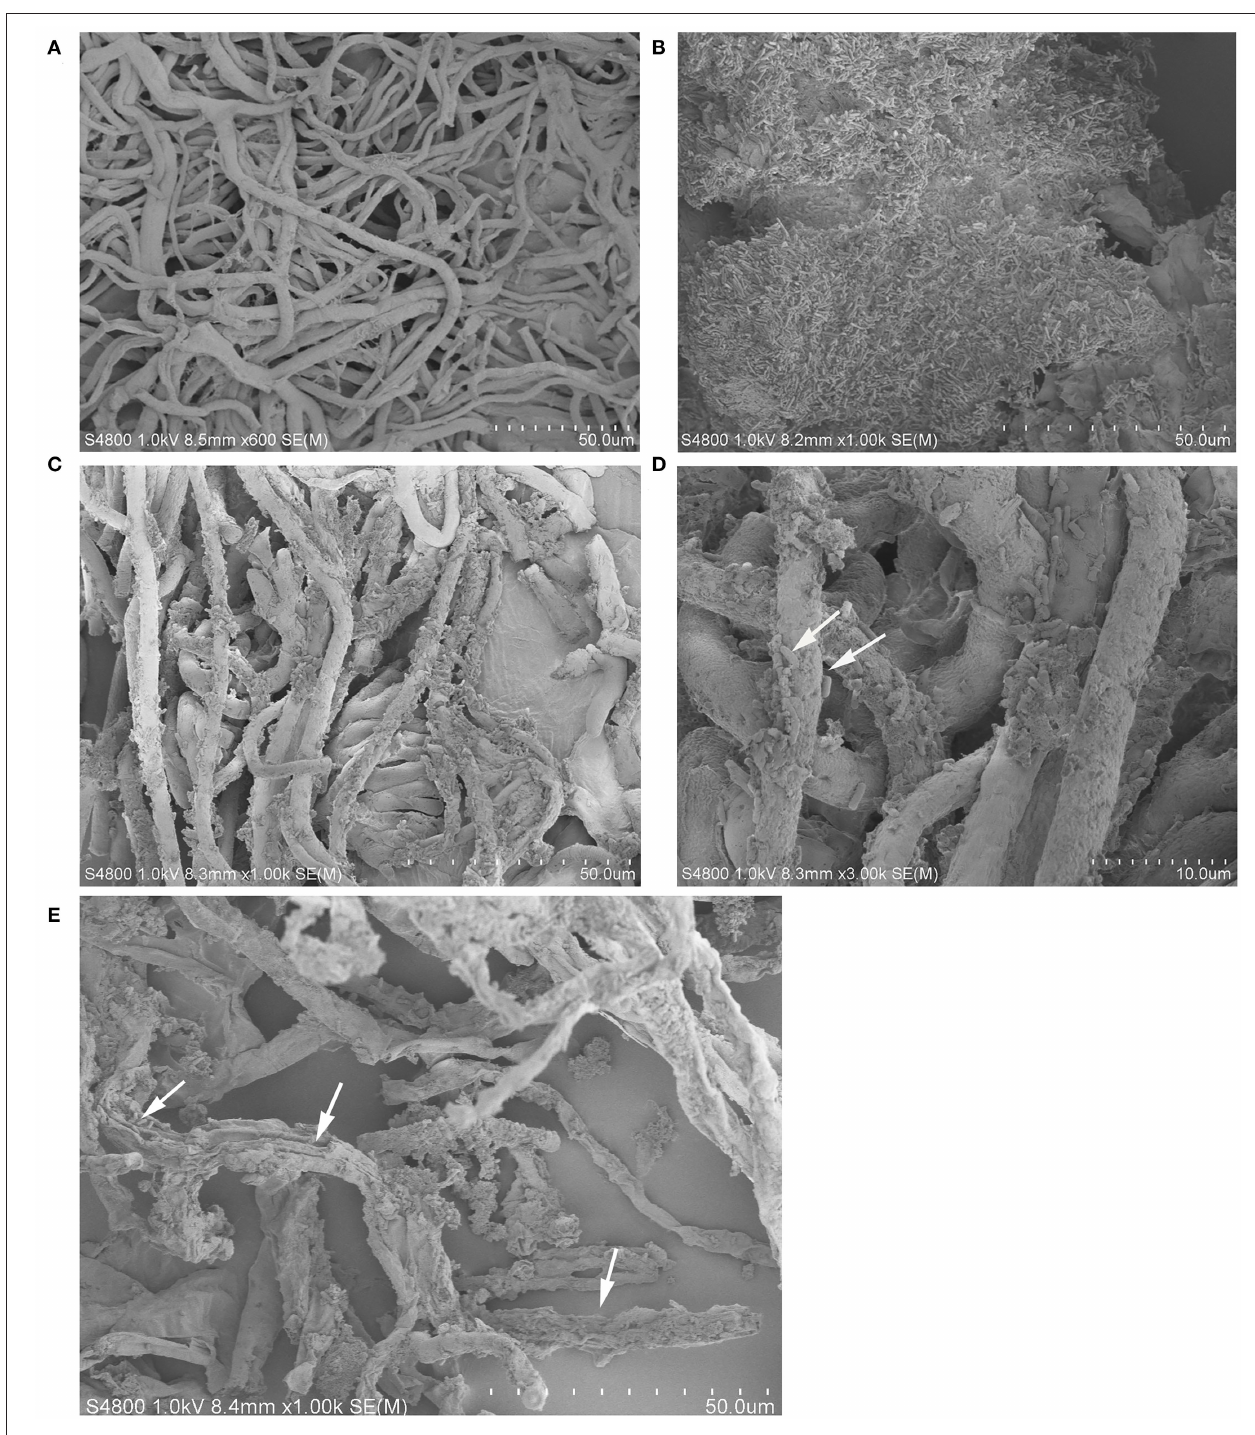
FIGURE 9 | Interaction between endophytic Bacillus K1 and Botrytis cinerea in grape fruit. (A) General state of B. cinerea mycelia on grape after inoculation for 2 days. (B) Colonization of endophytic bacteria in grape tissue after inoculation with K1 suspension for 2 days. (C,D) Endophytic bacteria K1 attached to mycelia surface at × 1,000 and × 3,000 by scanning electron microscopy, respectively. The white arrows highlighted the cells of Bacillus K1. (E) Irreversible deformation and disruption of mycelia at 7 days after treatment indicated active antifungal substance released by Bacillus K1. The white arrows indicated the K1 cells and pores on mycelia.